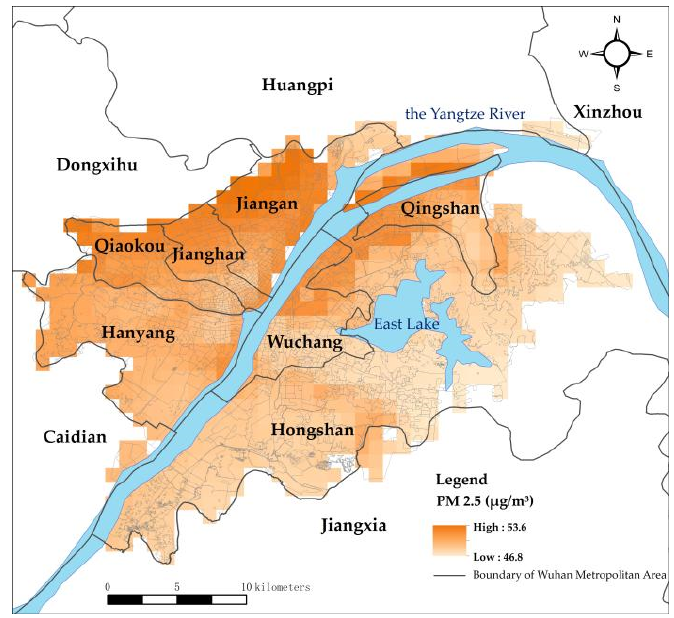
Figure 4. Distribution of PM 2.5 values and PM 2.5 NW–SE profile.